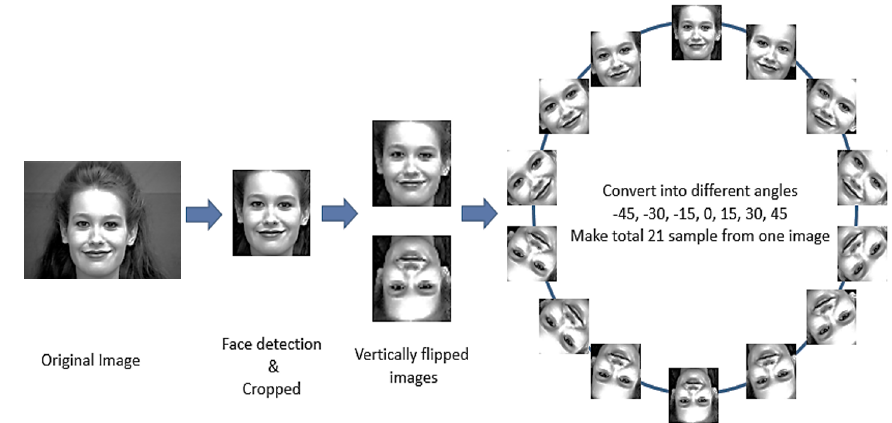
Figure 1. Workflow of the proposed methodology.